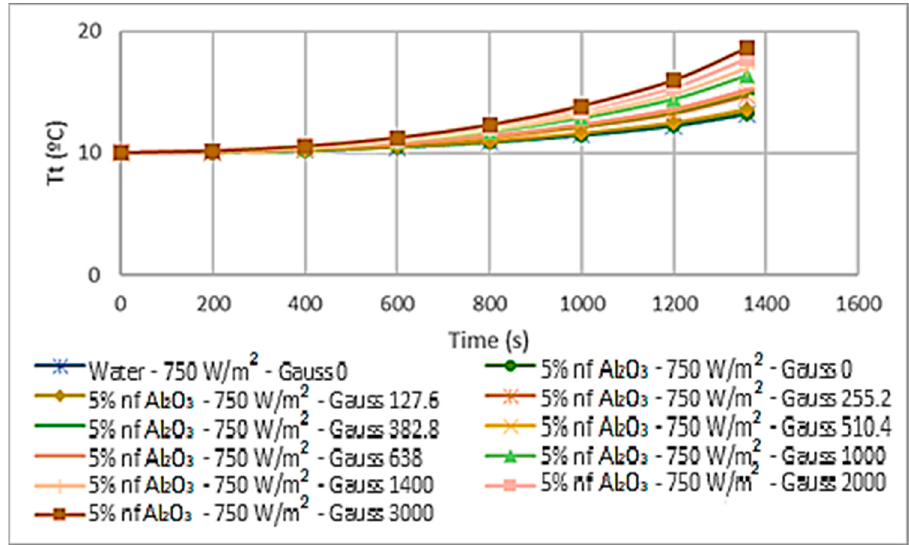
Figure 14. The dynamic temperature profile in the storage tank induced by PV-Th solar panels with different magnetic fields.